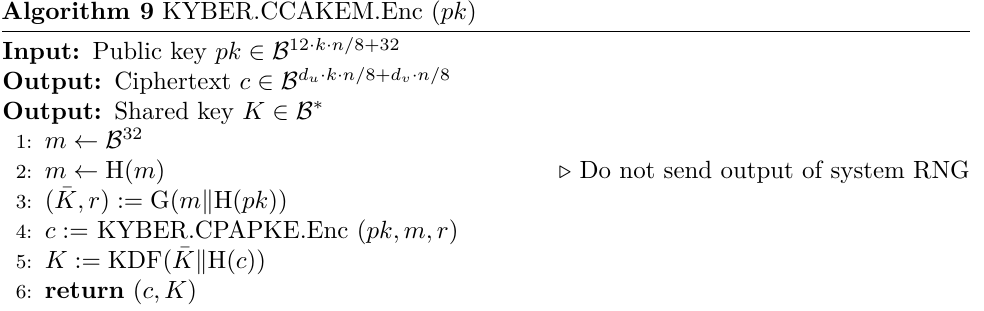
Algorithm 9 KYBER.CCAKEM.Enc ( pk )